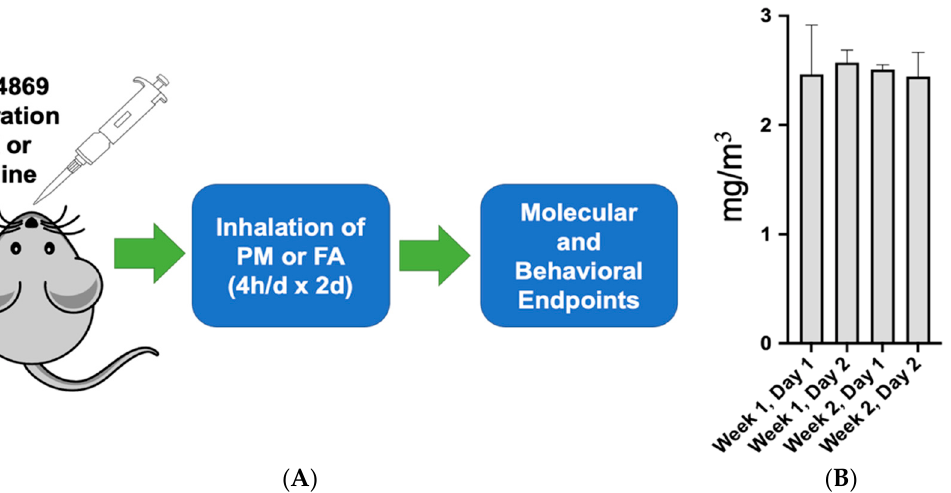
Figure 1. Study design and PM concentration. ( A ) Mice were subjected to 50 μ L of GW4869 (10 μ M) or 50 μ L of saline via oropharyngeal aspiration the day before and the day of exposure to either FA or PM (2.51 ± 0.08 mg/m 3 ). ( B ) PM concentration each exposure day (2 days total). PM (2.51 ± 0.08 mg/m 3 ). ( B ) PM concentration each exposure day (2 days